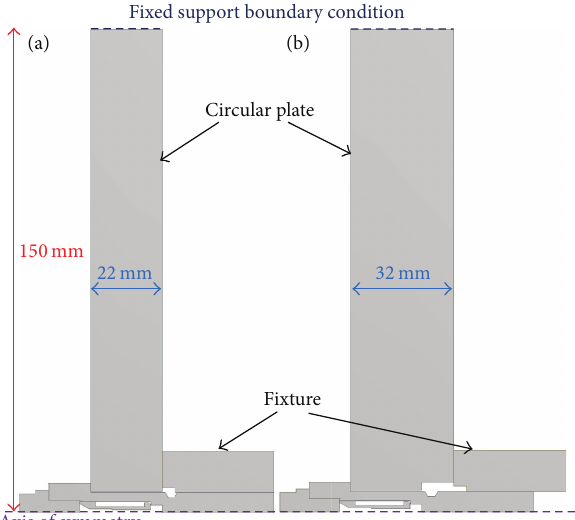
Figure 7: Geometric modeling and structure boundary condition of the bolt body, fixture, sleeve, and initiator with (a) the 22 mm thickness circular plate and (b) the 32 mm thickness circular